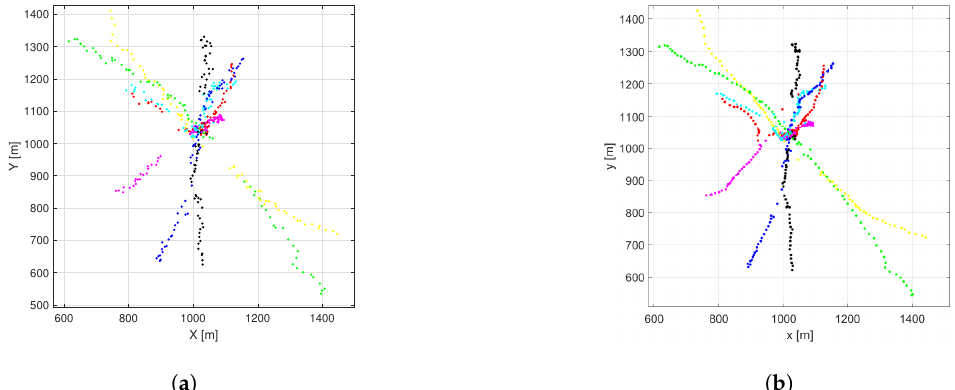
Figure 3. Estimated object positions in the example crossing trajectories scenario using the normal ( a ) and the proposed ( b ) PHD filter.